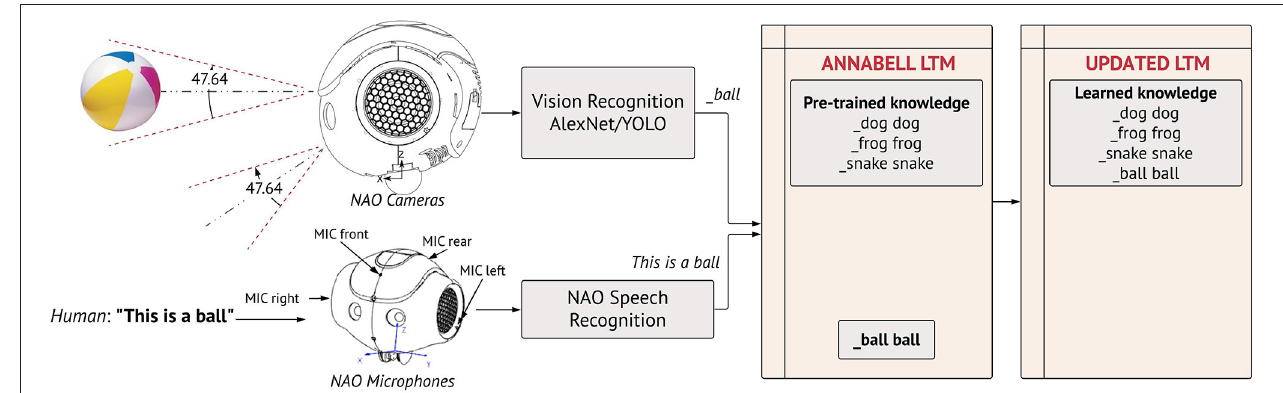
FIGURE 4 | Object learning. The robot is shown an object (ball) and the human dictates what the object is (This is a ball). The visual recognition system produces a label for the classified object. This label, merged with the phrase detected from NAO’s speech recognition module, are used in the cognitive model to generate the pair < _ball ball > that is stored permanently in the long-term memory (LTM). The LTM is autonomously amended to include the novel element as a learned information, which can be appropriately recalled during the mental action sequence execution. This setup is used to collect the target test data, by showing to NAO printed images of animals for Perception Tasks and physical objects in Manipulation